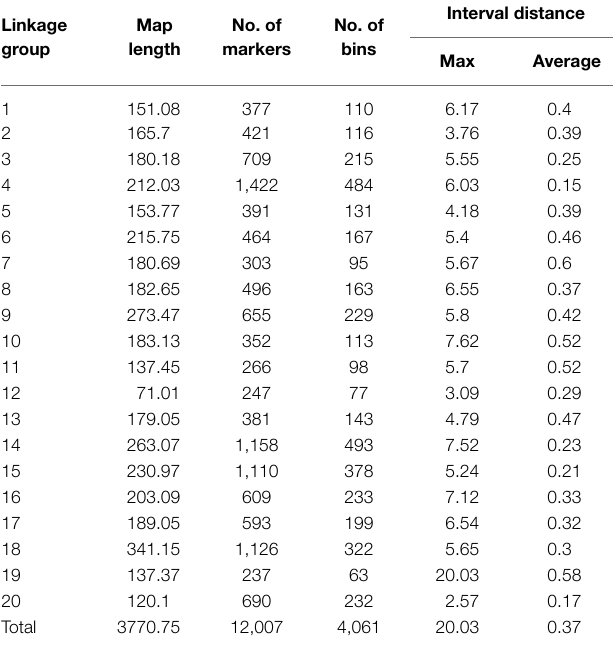
TABLE 3 | Information on linkage map of the SoyMAGIC population. Linkage